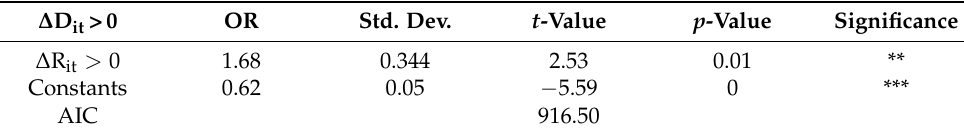
Table 4. Results of Wilcoxon signed-rank